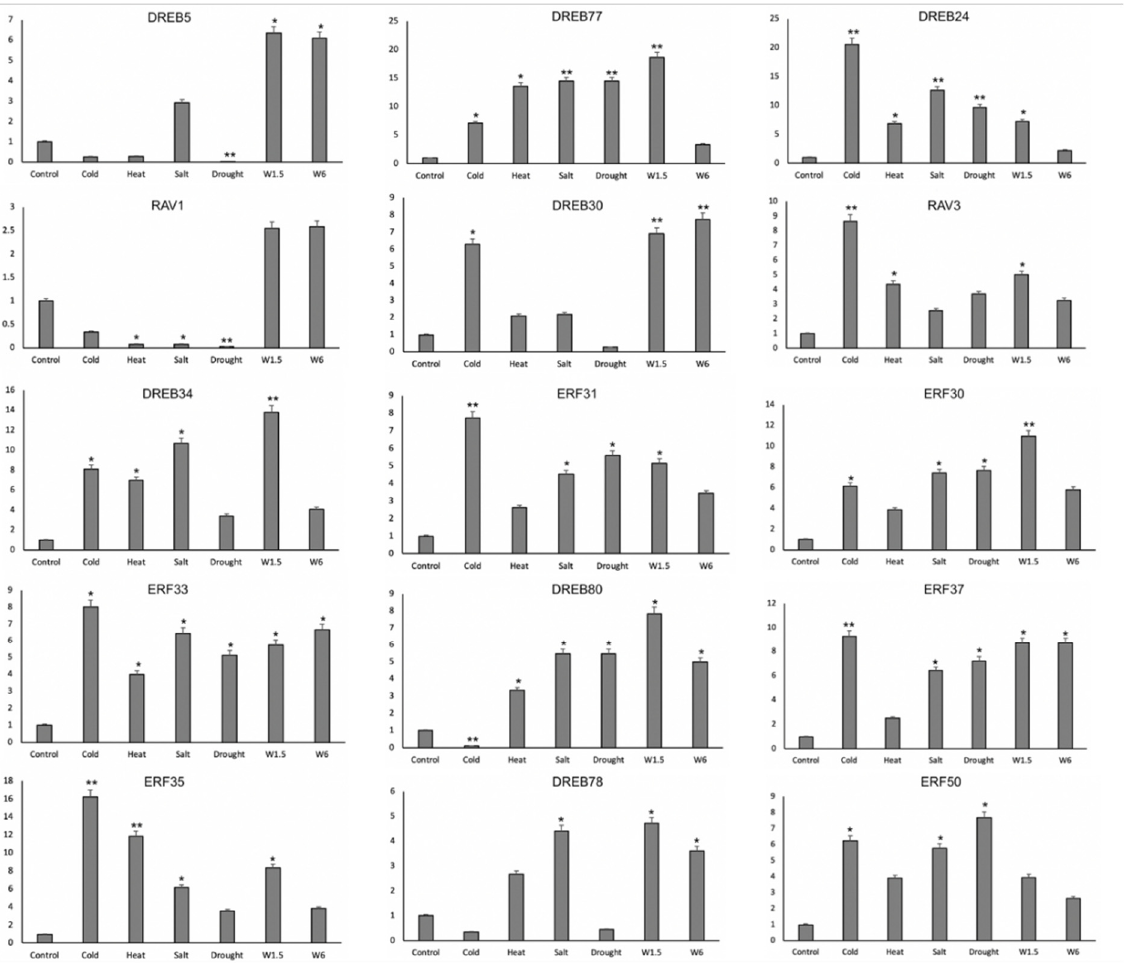
Figure 6. Expression profiling of fifteen selected ZmAP2 / ERFs in response to cold, heat, salt, drought, and wounding stress (W1.5, W6) treatments. Data were normalized to Actin2 and asterisks on bars indicate SD (* p < 0.05, ** p < 0.01).